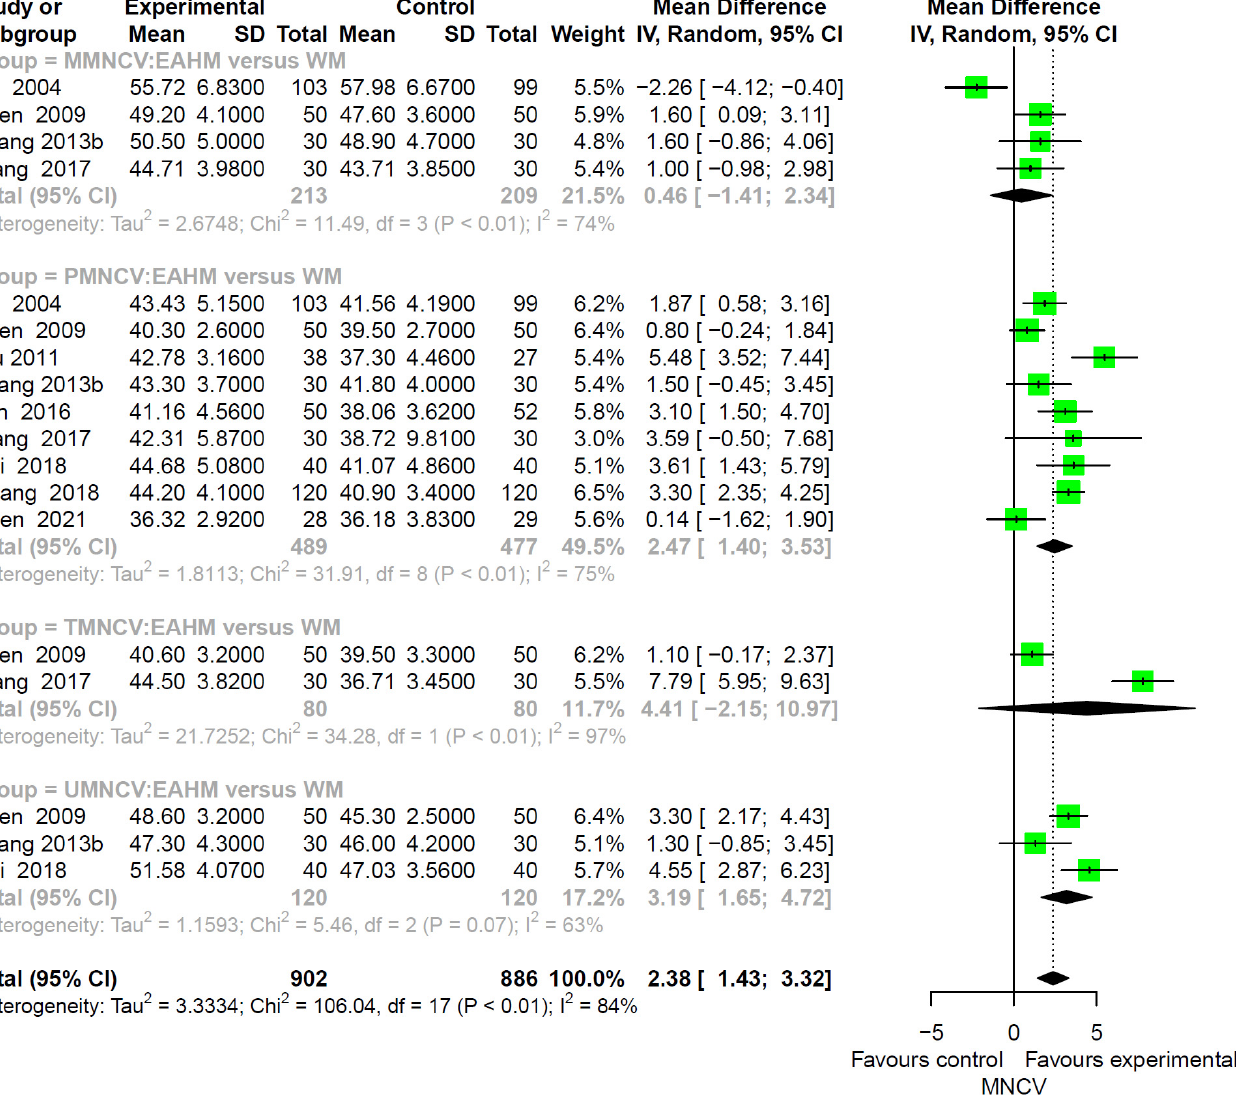
Figure 5. Forest plot of the trials reporting the effect of East Asian herbal medicine monotherapy on motor nerve conduction velocity for peripheral neuropathy.